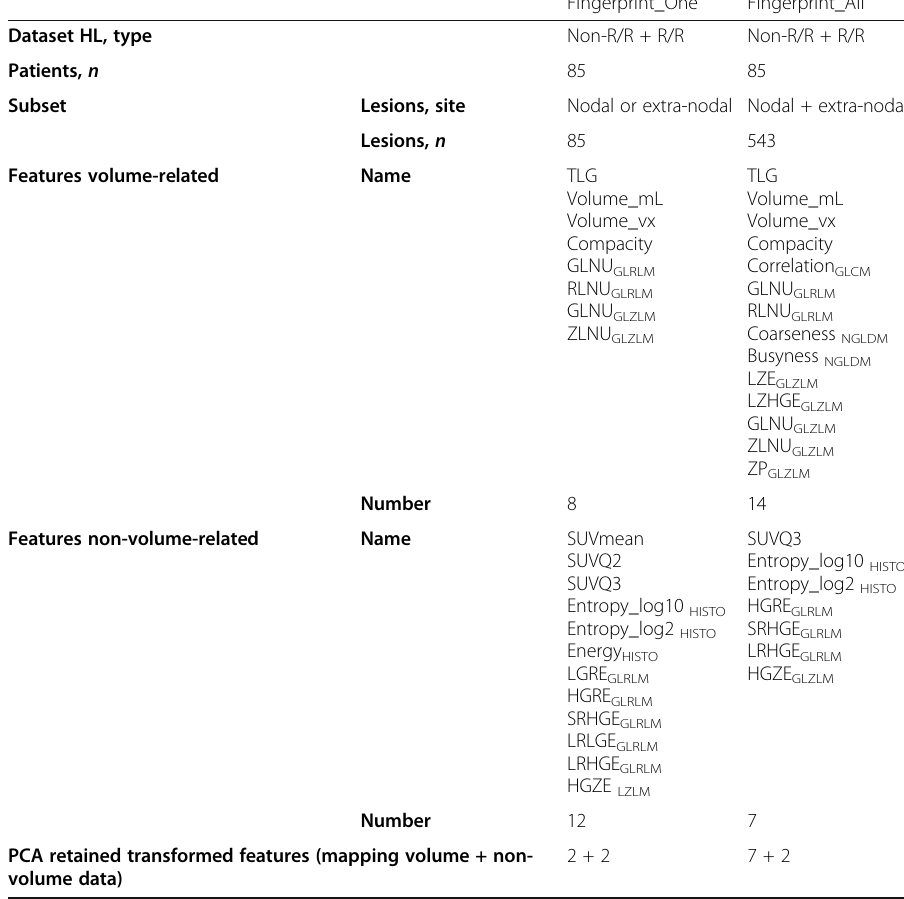
Table 4 Fingerprints construction for inter-patient similarity